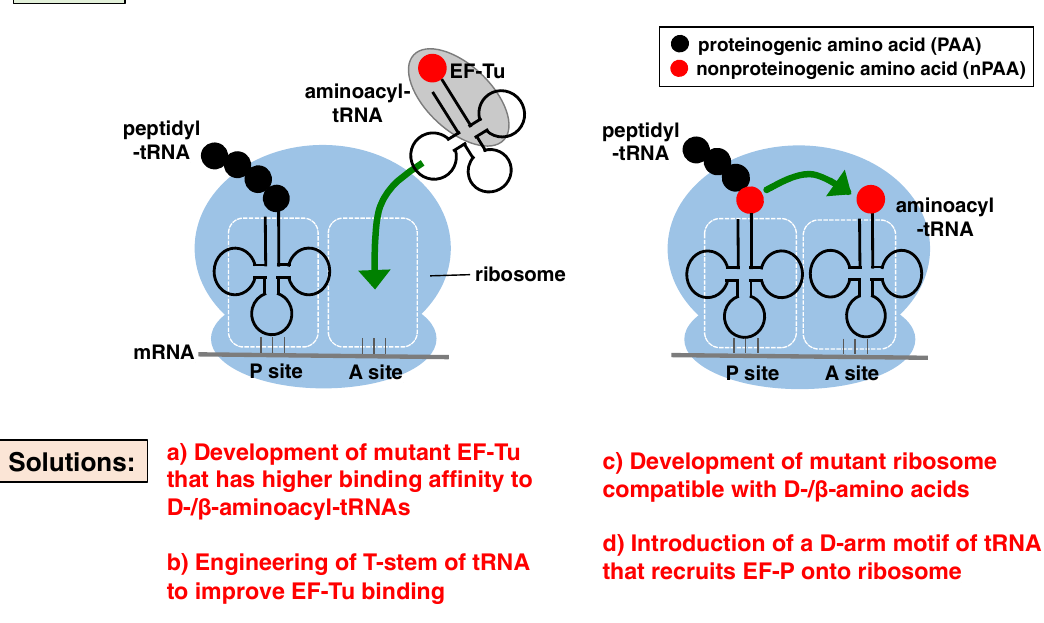
Figure 1. Reasons for the low incorporation efficiency of exotic nonproteinogenic amino acids (nPAAs). Green arrows indicate the slow accommodation of nPAA-tRNA ( 1 ) and slow peptidyl transfer between nPAAs ( 2 ), which are direct causes of low incorporation efficiency. Solutions to these issues for improving the incorporation of nPAAs (discussed in the main text) are listed in a–d. EF-Tu: elongation factor-thermo unstable; EF-P: elongation